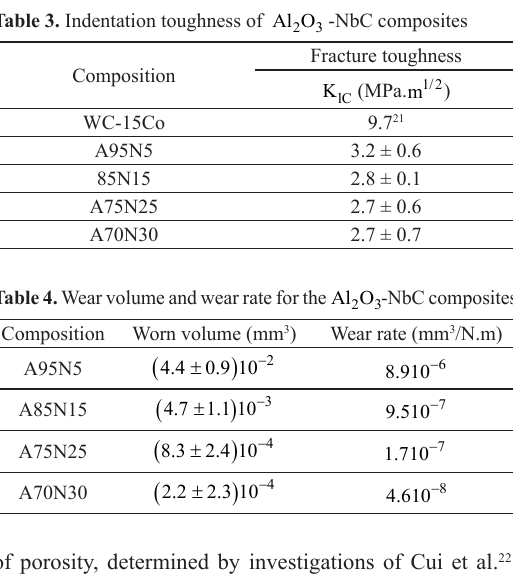
O samples for various NbC contents 2 3 Predicted hardness (GPa)